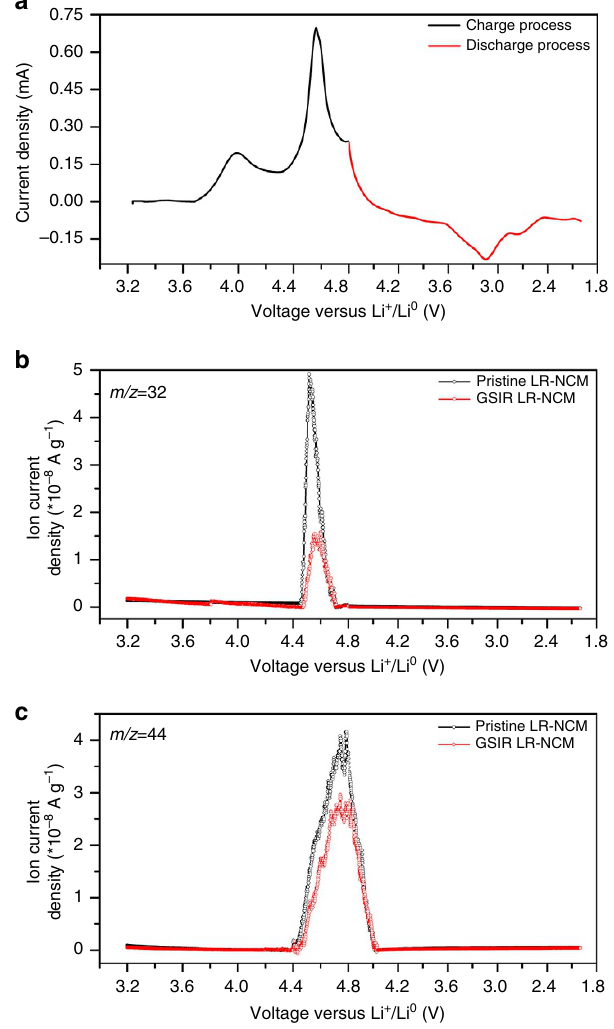
Figure 5 | Operando DEMS. ( a ) Initial cyclic voltammetry (CV) curve of the pristine and GSIR LR-NCM electrode. ( b ) Oxygen gas profile of the initial charge–discharge process for the pristine and GSIR LR-NCM electrode. ( c ) Carbon dioxide gas profile of the initial charge–discharge process as the above electrodes. The loading density mass for these two electrodes are the same about 7.76mg. The scan rate was B 0.1mVs (cid:2) 1 , and the potential range was between 2.0 and 4.8V versus Li þ /Li 0 at an elevated temperature of 55 (cid:2)